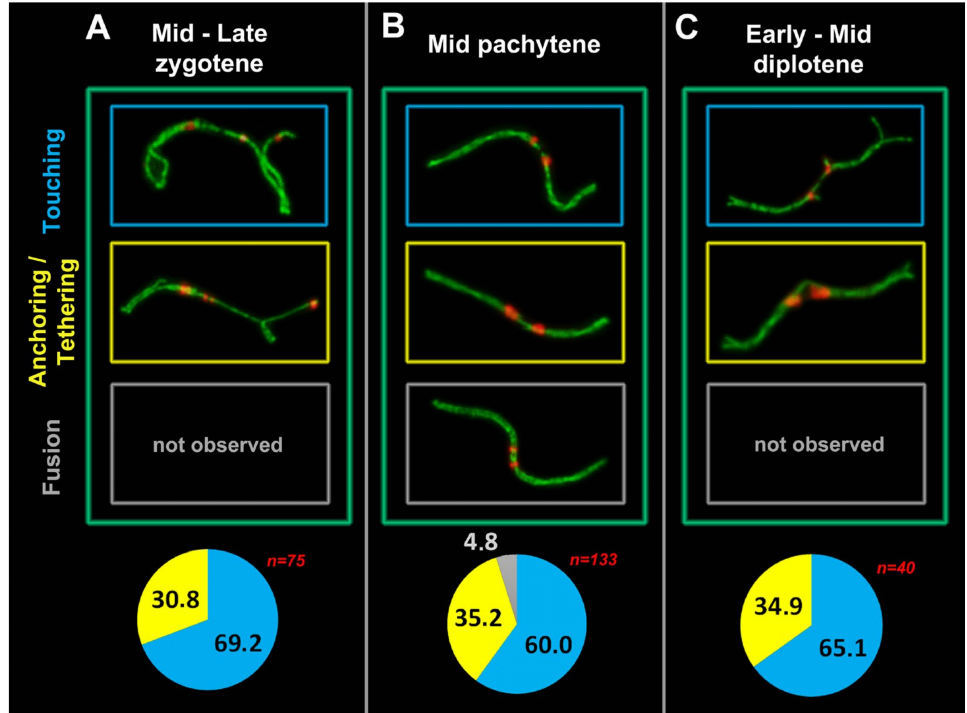
Figure 5. Types of meiotic contacts at the different prophase I substages in E. alaicus : mid–late zygotene ( A ), mid pachytene ( B ) and early–mid diplotene ( C ). ‘Touching’, ‘anchoring/tethering’, and ‘fusion‘ types were counted in cells with chromosome connections only. Proportions of connection types (bottom diagrams): blue color corresponds to ‘touching’, yellow to ‘anchoring/tethering’, and gray to ‘fusion’. ‘Fusion’ type was found only at the pachytene. Red numbers are the counted spermatocytes. The color of the frames corresponds to the types of contacts. Microphotos and data from B section were taken from